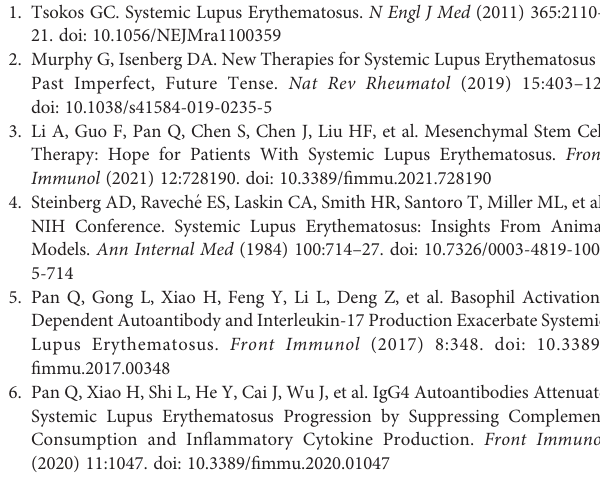
Gene expression plasmid Genetic